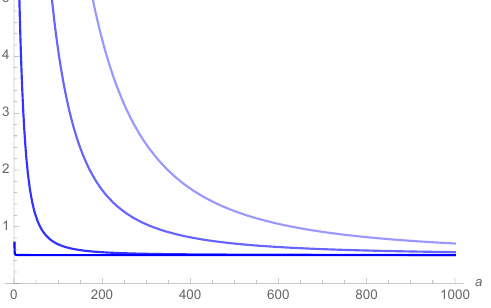
Figure 4 . Plot of (cid:22) k s (cid:0) (cid:22) k as a function of a for (cid:15) = 10 (cid:0) 10 , where the shading runs through the same range of y 1 as in (cid:12)gure 3 (from y 1 = 0 at the bottom to y 1 = 200 at the top). In all cases, the di(cid:11)erence eventually approaches 1 = 2, consistent with eq. (5.20). For example, when a =